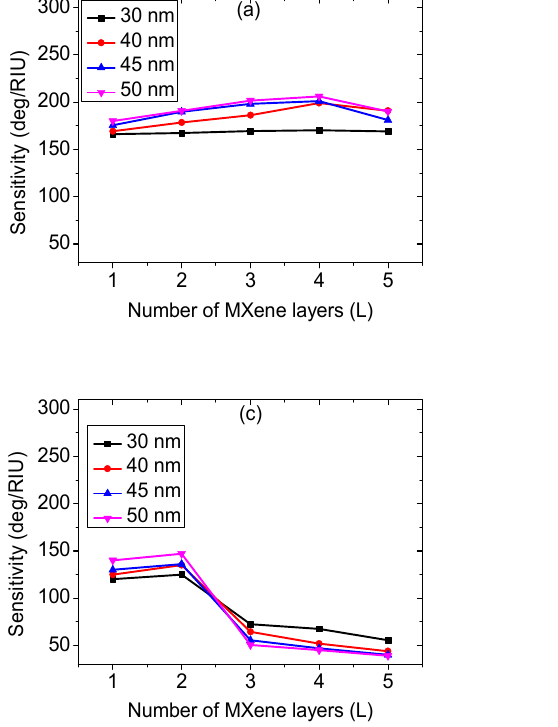
Figure 4. Sensitivity versus the number of Ti 3 C 2 T x sheets with various thicknesses of Ag layer at Si thicknesses of ( a ) 1, ( b ) 2, ( c ) 3, and ( d ) 4 nm. Small changes in the RI of the analyte lead to a significant shift in the angular position of the reflectance dip. We analyzed the resonance angle shift and sensitivity of the proposed sensor (Ag of 50 nm/Si of 4 nm/a monolayer of Ti 3 C 2 T x ) for varied fat concentrations (0.0%, 1.5%, 3.3%, 6.6%, 10%, and 33.3%) in milk. The fat concentrations in milk and the corresponding RI, angular position of the resonance dip, shift of the resonance angle, and sensitivity are summarized in Table 3. Figure 5 shows that any small change in the fat con- centration, and hence in the RI, can be easily sensed, which reflects a shift in the resonance dip angular position. The figure also shows that increasing the fat concentration leads to a drop in the sensitivity of the sensor. The sensitivity is found to be 350, 300.01, 281.32, 239.29, and 185.85 deg./RIU for fat concentrations of 0.0%, 1.5%, 3.3%, 6.6%, 10%, and 33.3%, respectively. The maximum sensitivity of 350 deg./RIU can be found at a fat concentration of 1.5% in milk. The sensitivity drop with the increase in the milk fat concentration can be attributed to an increase in the index of refraction of the analyte. Therefore, the proposed sensor can be employed efficiently for detecting the fat concentration in